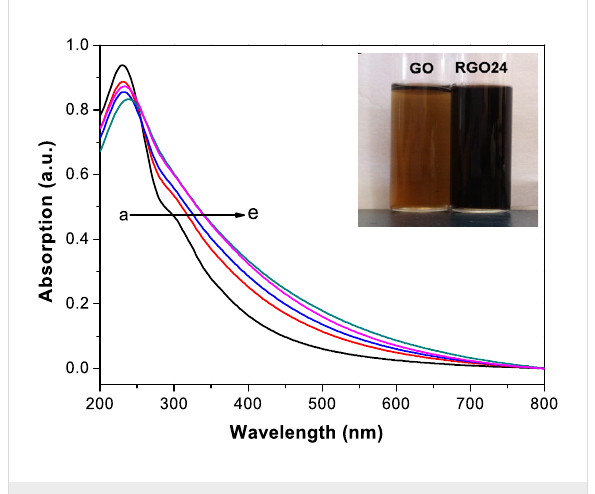
Figure 1: UV–vis spectra of (a) GO, (b) RGO4, (c) RGO12, (d) RGO24, and (e) RGO36 solution (20 μ g mL − 1 ). The inset is an image of GO and